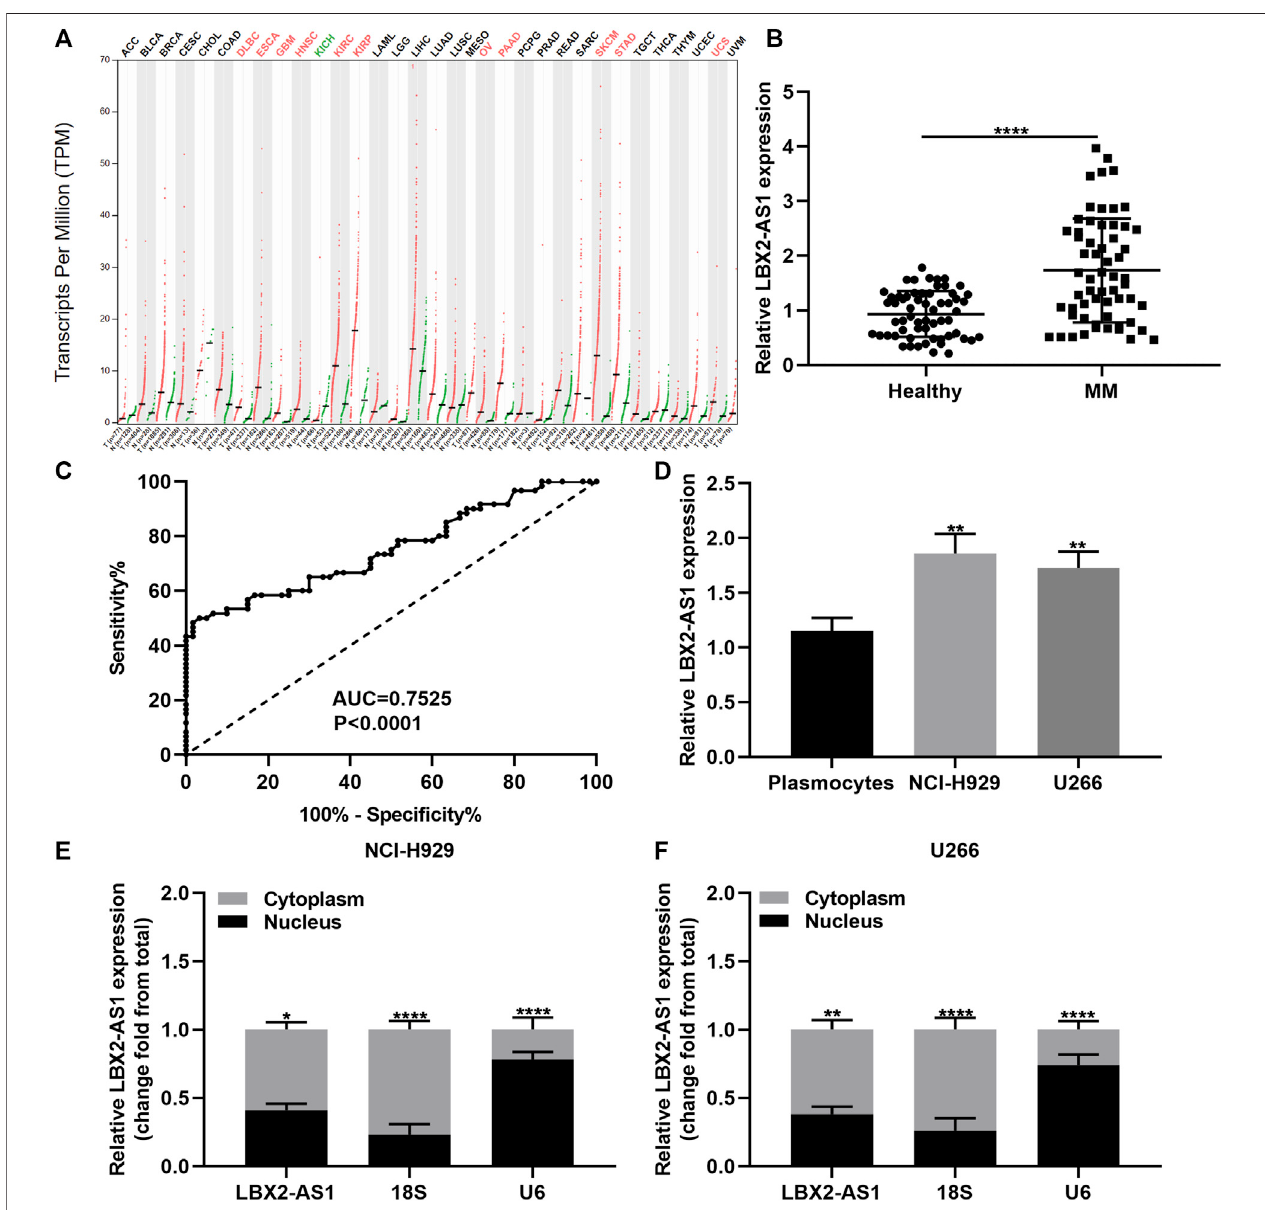
FIGURE 1 | LBX2-AS1 is highly expressed in MM and could be a diagnostic marker of MM. (A) LBX2-AS1 expression in various cancers by the GEPIA online database. (B) RT-qPCR for LBX2-AS1 expression in serum samples from 60 paired MM and healthy subjects. (C) ROC of circulating LBX2-AS1 expression. (D) RT- qPCRforLBX2-AS1expressioninplasmocytes,NCI-H929andU266cells. (E,F) RT-qPCRforLBX2-AS1expressionincytoplasmandnucleusofNCI-H929andU266 cells. * p < 0.05; ** p < 0.01; **** p <